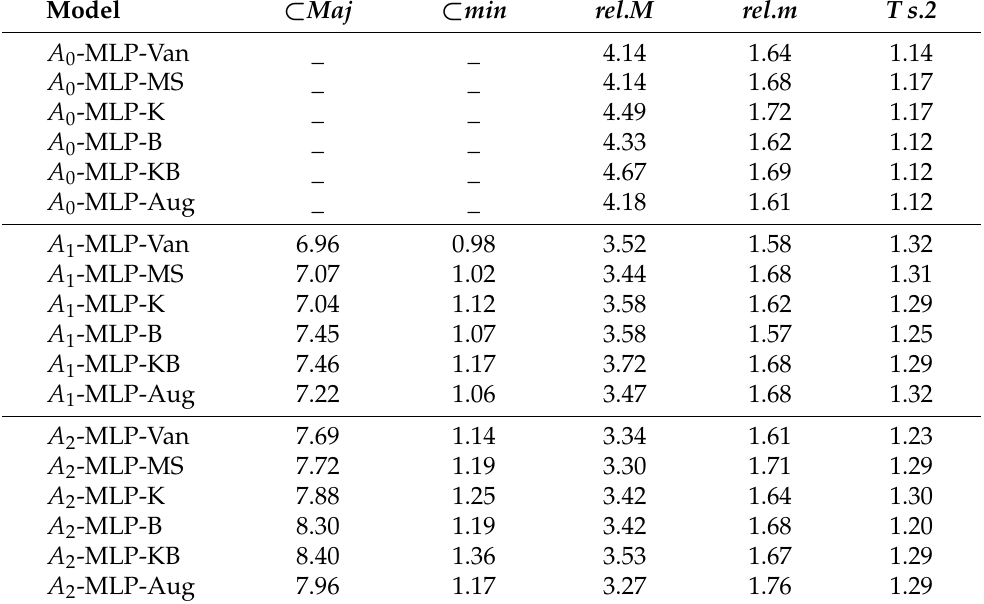
Table 9. Percentage of errors corresponding to inclusions or usual chord substitution